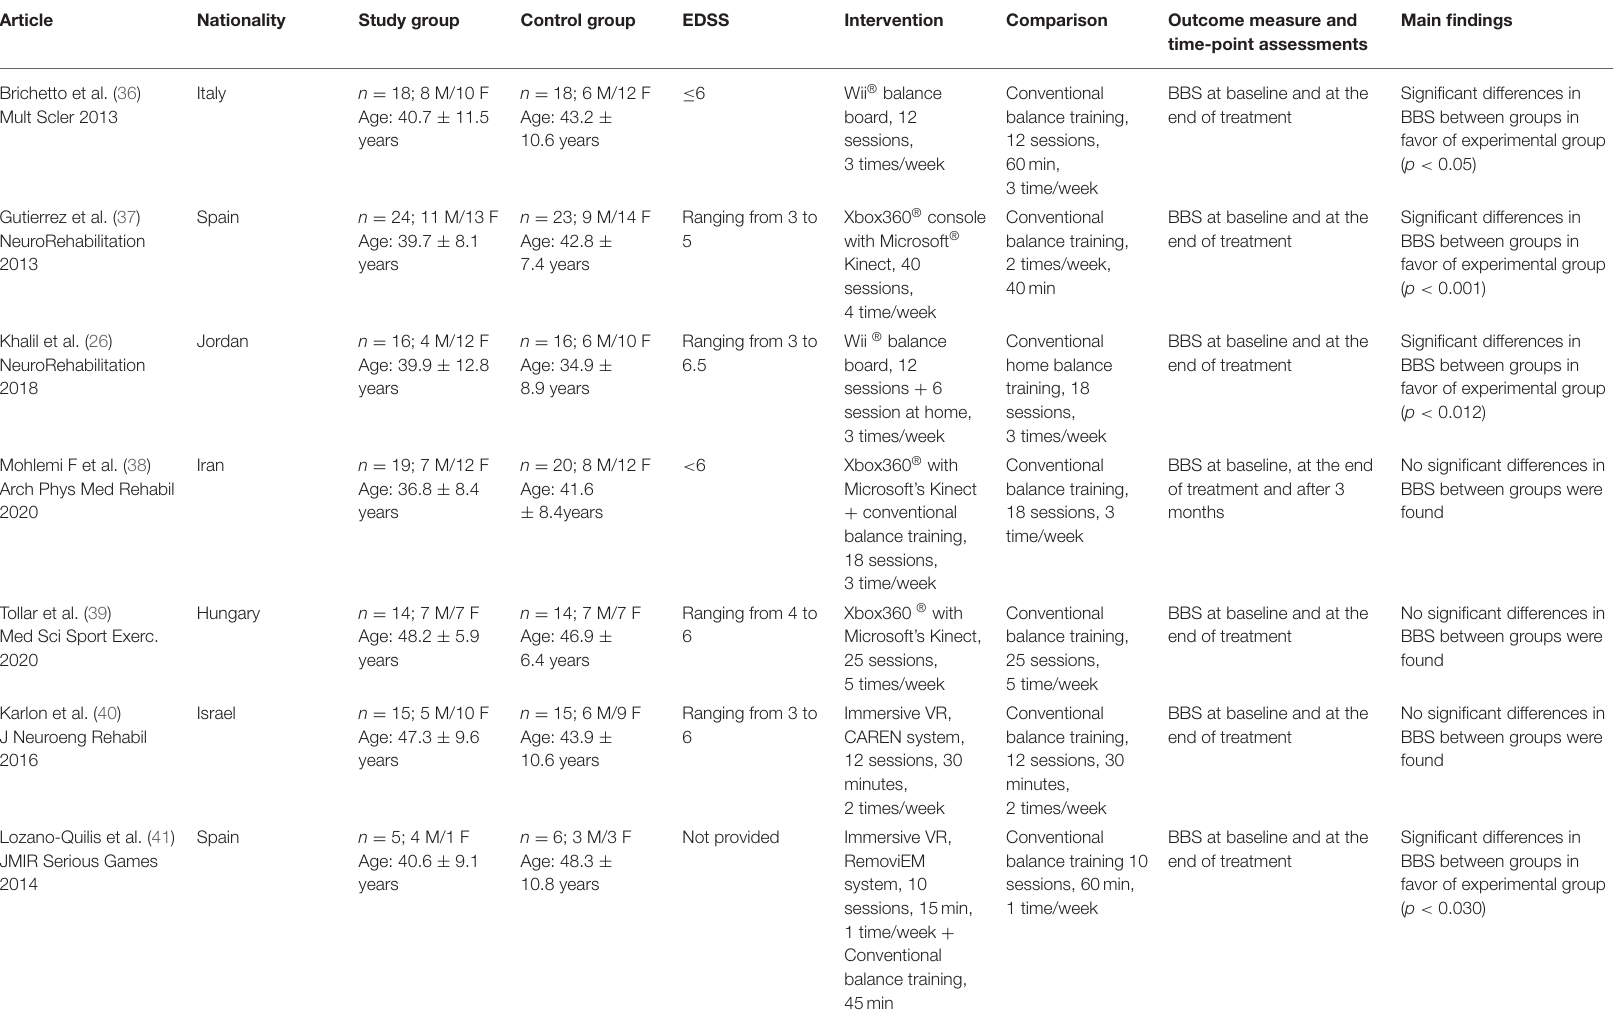
TABLE 2 | Main characteristics of the randomized controlled trials included in the present systematic